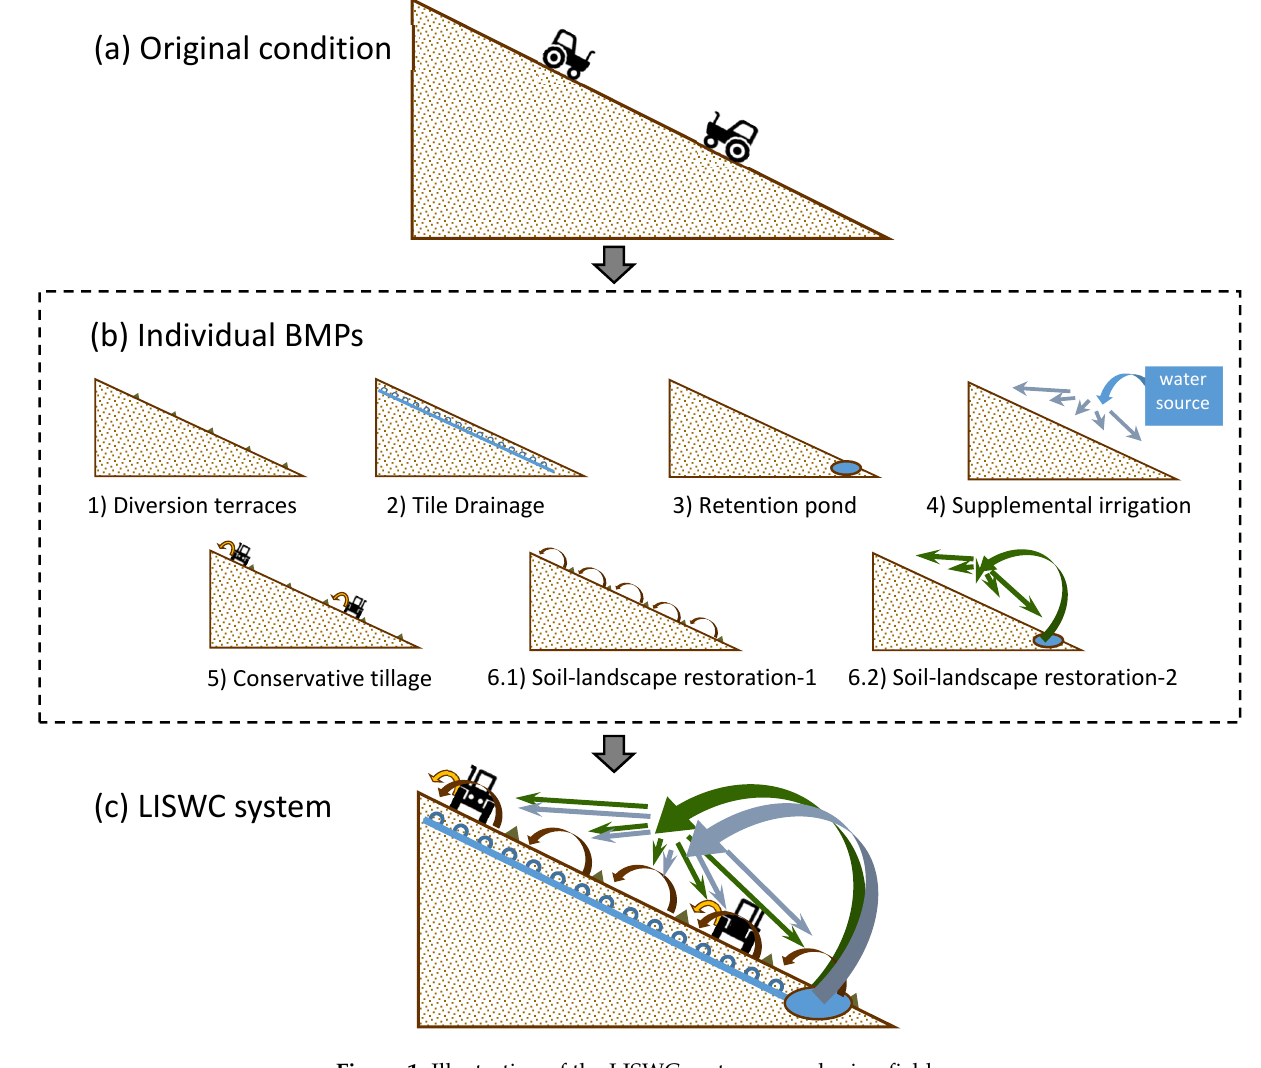
Figure 1. Illustration of the LISWC system on a sloping field.